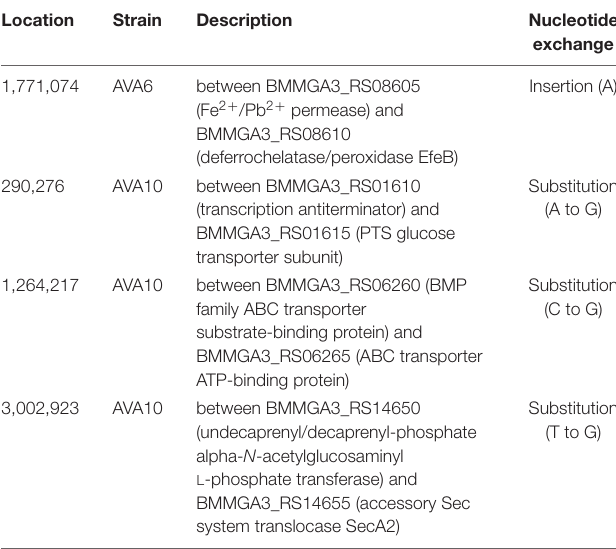
TABLE 4 | Intergenic SNPs in B. methanolicus ALE strains AVA6 and AVA10.